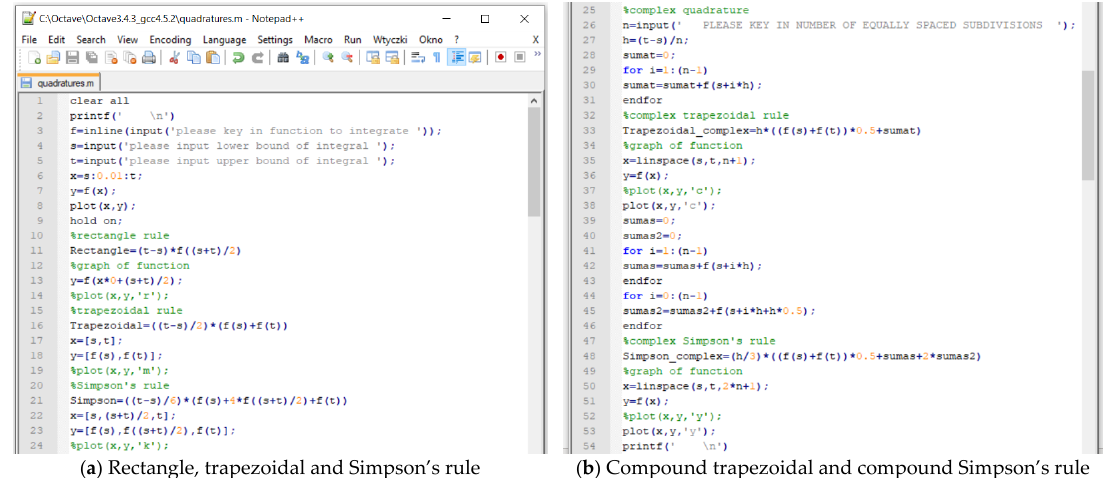
Figure 4. Result of Octave 3.4.3 software operations.